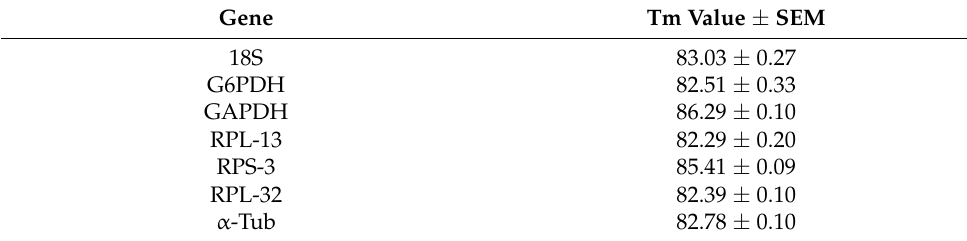
Figure 1. Melting curves for the seven candidate reference genes. The x axis is the temperature and the y axis is the Derivative Reporter. Table 3. Tm values of seven